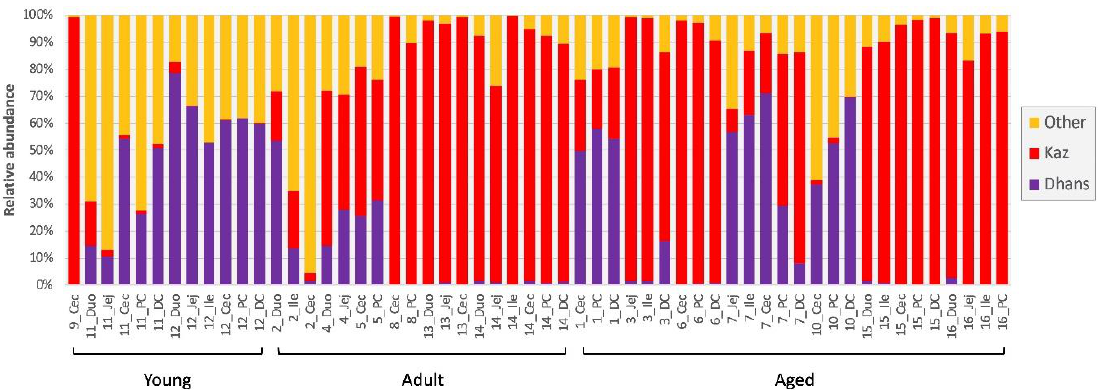
Figure 3. Prevalence and abundance of K. pintolopesii (Kaz) and D. hansenii (Dhans) in macaque GIT samples.